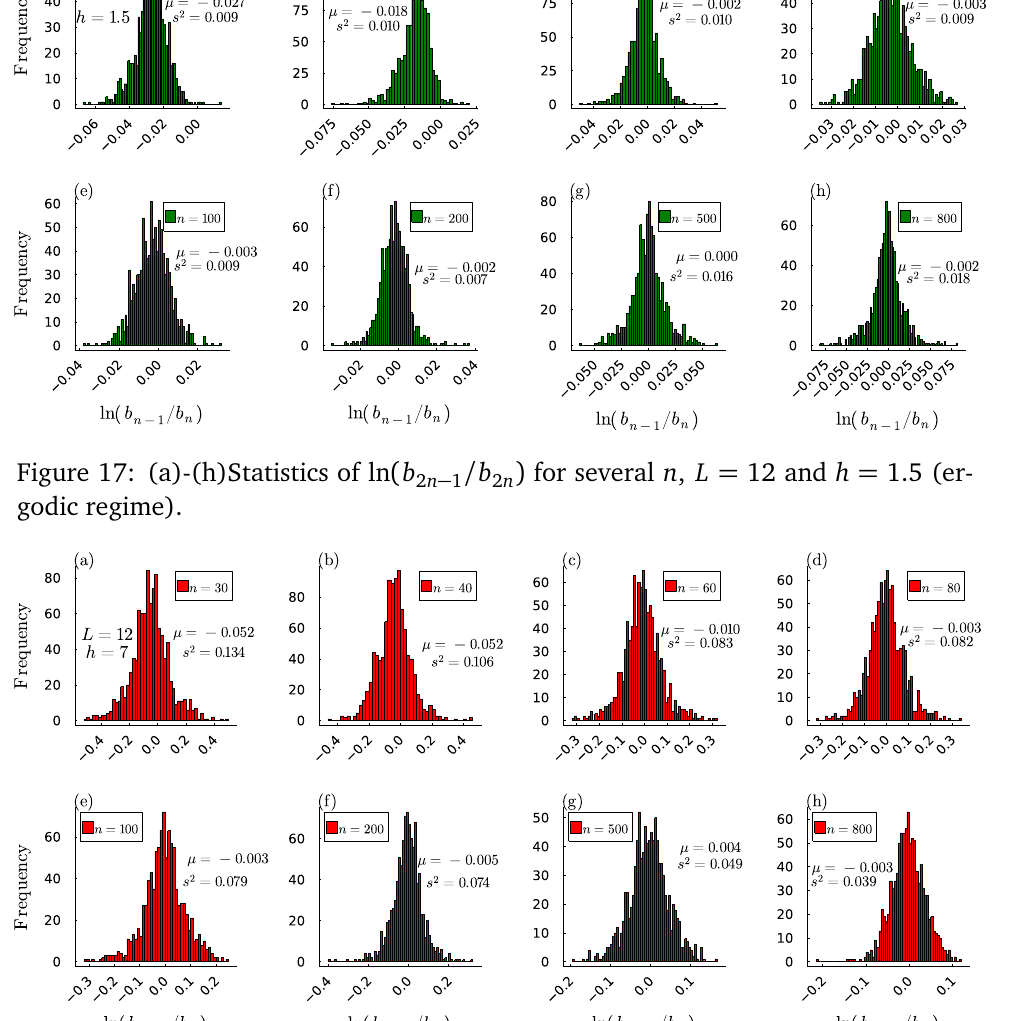
) for several n , L = 12 and h = 7 (MBL